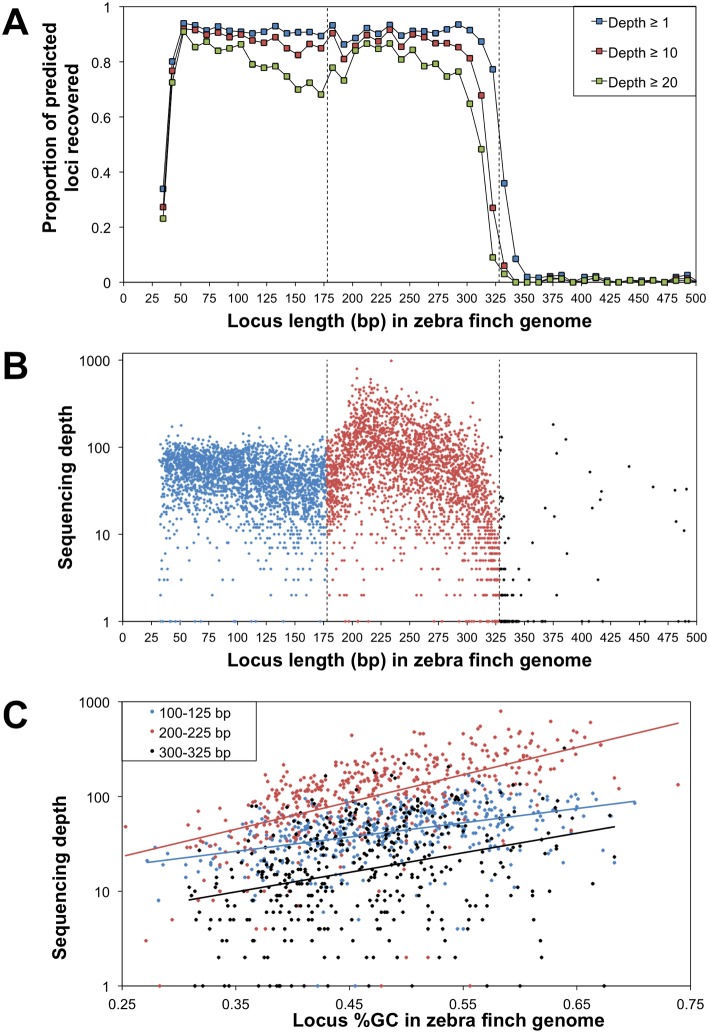
Recovery and sequencing depth for predicted, single-copy ddRAD loci in the empirical zebra finch data.(A) Proportion of predicted loci recovered at three different minimum depth thresholds as a function of predicted fragment length. Each data point represents the proportion of ∼140–220 predicted loci recovered in a given 10 bp size range. Dashed vertical lines represent the upper and lower bounds of the size range isolated from the agarose gel. (B) Sequencing depth for recovered (depth ≥1), single-copy loci in the 32–500 bp size range (includes 5,232 of 5,783 predicted loci in the 38–328 bp size range). (C) The relationship between GC content and sequencing depth for zebra finch ddRAD loci. Data are shown for predicted, single-copy loci recovered at a depth ≥1 in three selected subsets of the overall size range (n = 502, 466, and 445 loci in the 100–125, 200–225, and 300–325 bp size ranges, respectively). The predicted length and GC content of each locus are based on the full-length fragment in the reference genome, inclusive of the SbfI and EcoRI restriction sites on either end. Note that the y-axis is on a logarithmic scale in (B) and (C).